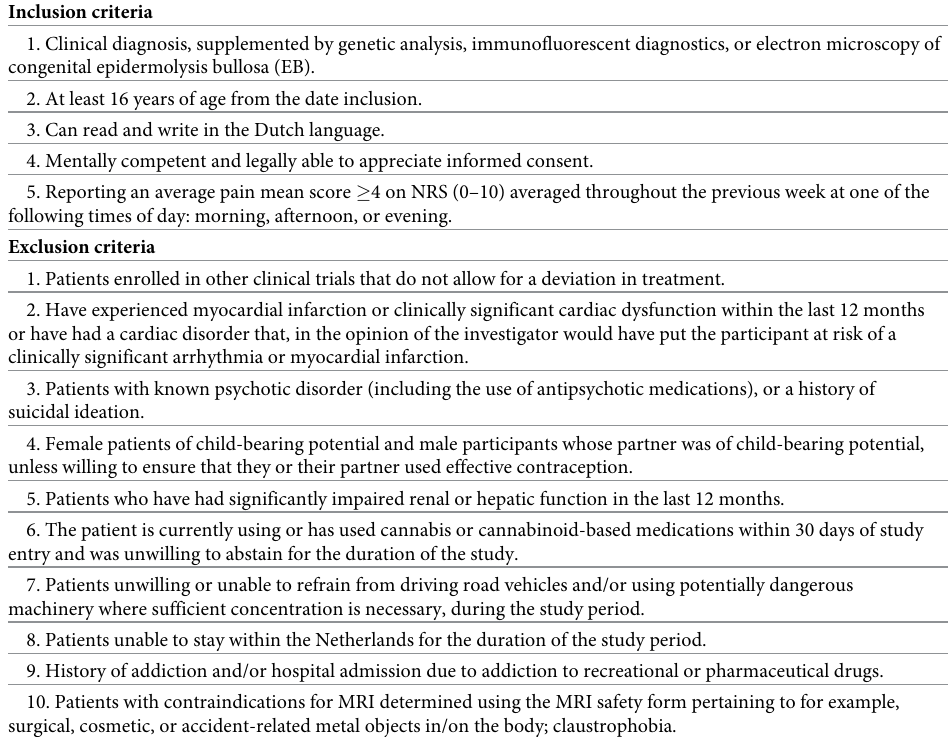
Table 1. Inclusion and exclusion